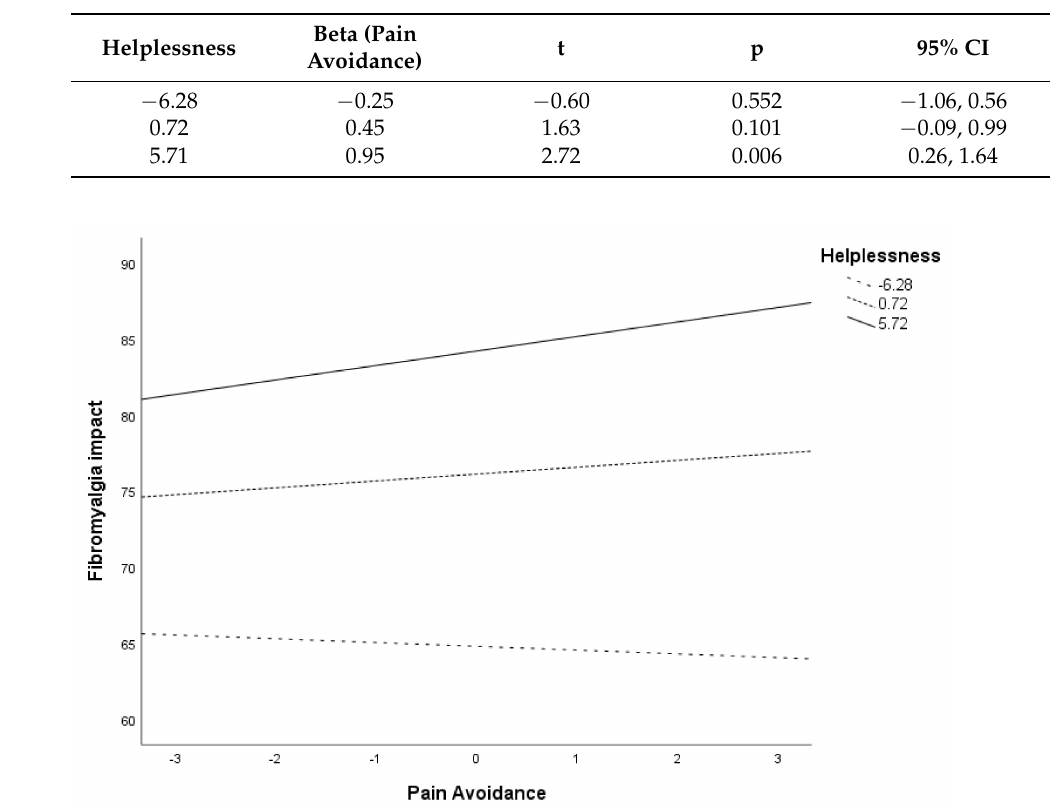
Table 6. Conditional effects of pain avoidance on fibromyalgia impact at values of helplessness.